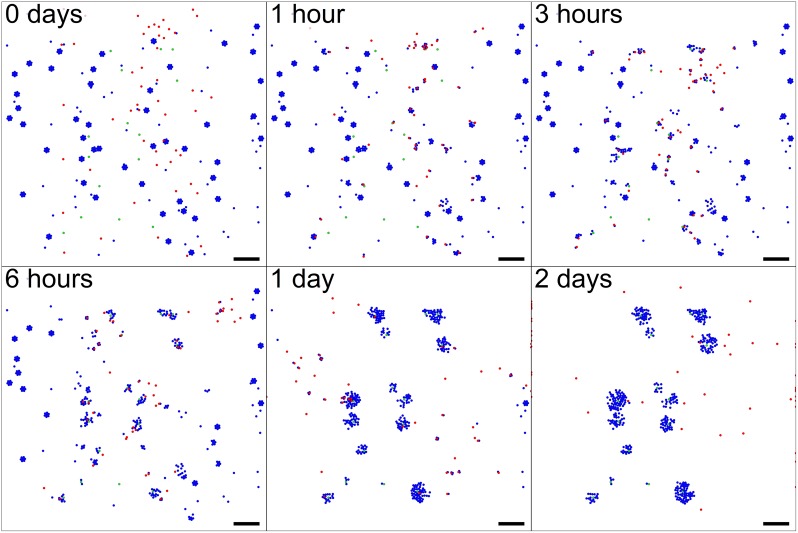
“Biorobots” example.Director cells (green) release a chemoattractant c1 to guide worker cells (red). Cargo cells (blue) release a separate chemoattractant c2. Unadhered worker cells chemotax towards ∇c2, test for contact with cargo cells, form adhesive bonds, and then pull them towards the directors by following ∇c1. If c1 exceeds a threshold, the worker cells release the cargo and return to seek more cargo cells, repeating the cycle. Bar: 200 μm. A video is available at S5 Video.